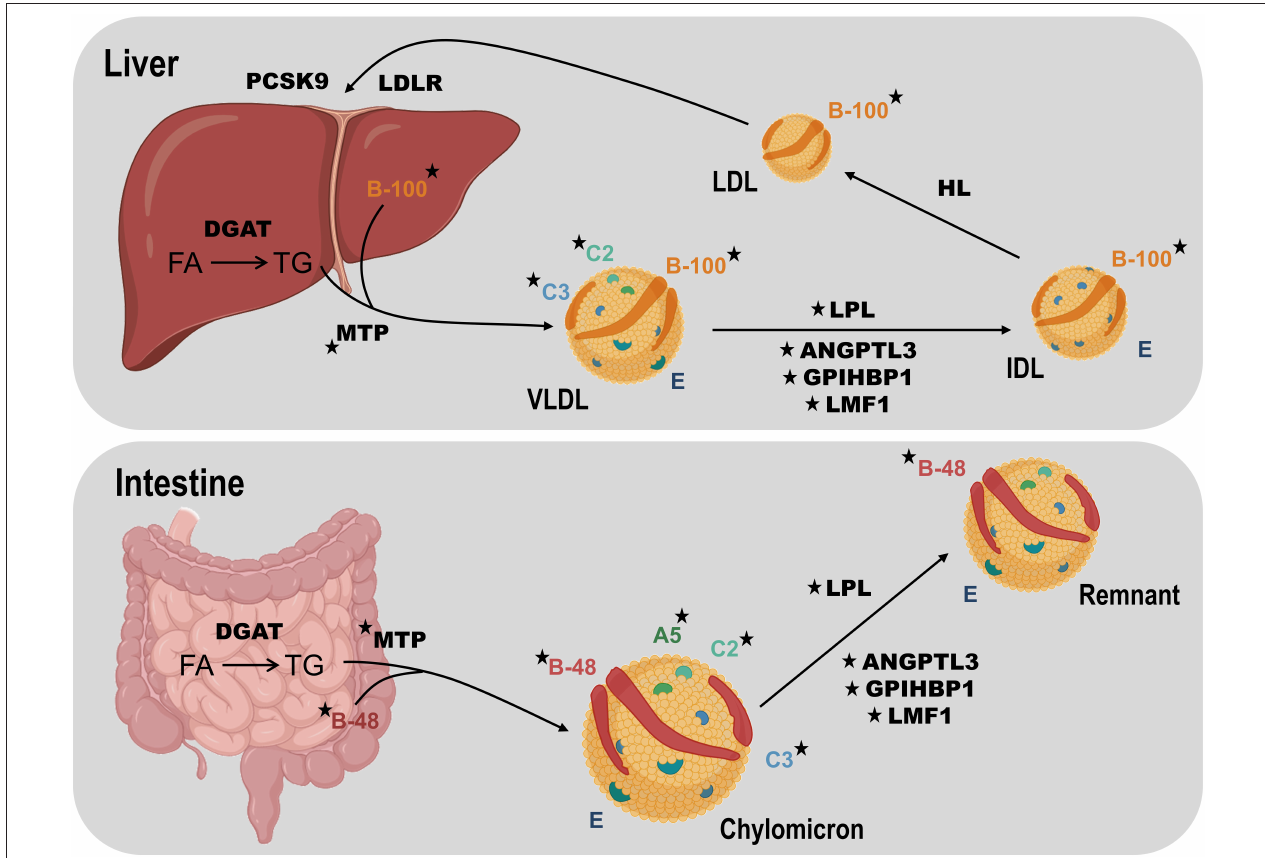
FIGURE 2 | Overview of TG metabolism focusing on human disease genes. TG-rich lipoprotein assembly requires TG synthesis from fatty acids (FA) in the intestine or liver using tissue-specific isoforms of diacylglycerol acyltransferase (DGAT). Microsomal triglyceride transfer protein (MTP) fuses TG, cholesterol and phospholipids, with tissue-specific isoforms of apolipoprotein (apo) B: intestinal B-48 to form chylomicrons and hepatic B-100 to form very-low density lipoprotein (VLDL). Chylomicrons enter plasma through the thoracic duct while the liver secretes VLDL directly into the bloodstream. Lipoprotein lipase (LPL) is the key enzyme for hydrolysis of both circulating chylomicrons and VLDL, producing chylomicron remnants and intermediate-density lipoprotein (IDL) particles, respectively. Chylomicron remnant and IDL clearance by the liver is mediated by apo E (not shown). IDL is further hydrolyzed by hepatic lipase (HL) to generate low-density lipoprotein (LDL), which is cleared